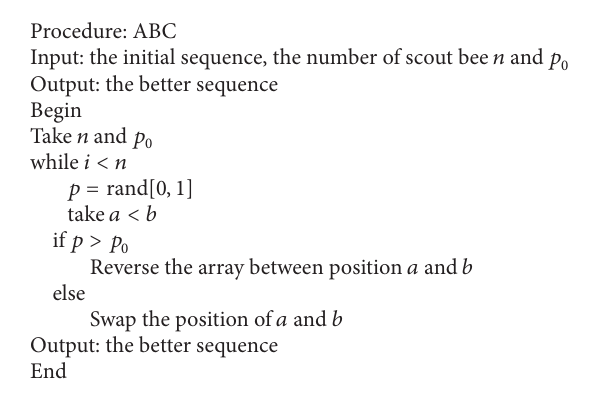
Pseudocode 1: Pseudocode of an ABC